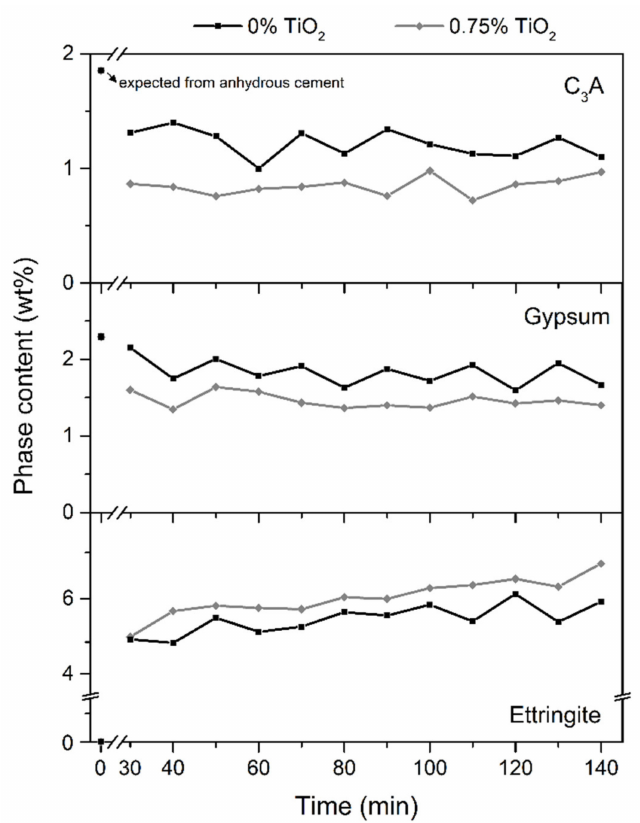
Figure 3. C 3 A, gypsum, and ettringite content of pastes over time obtained by in situ XRD- Rietveld